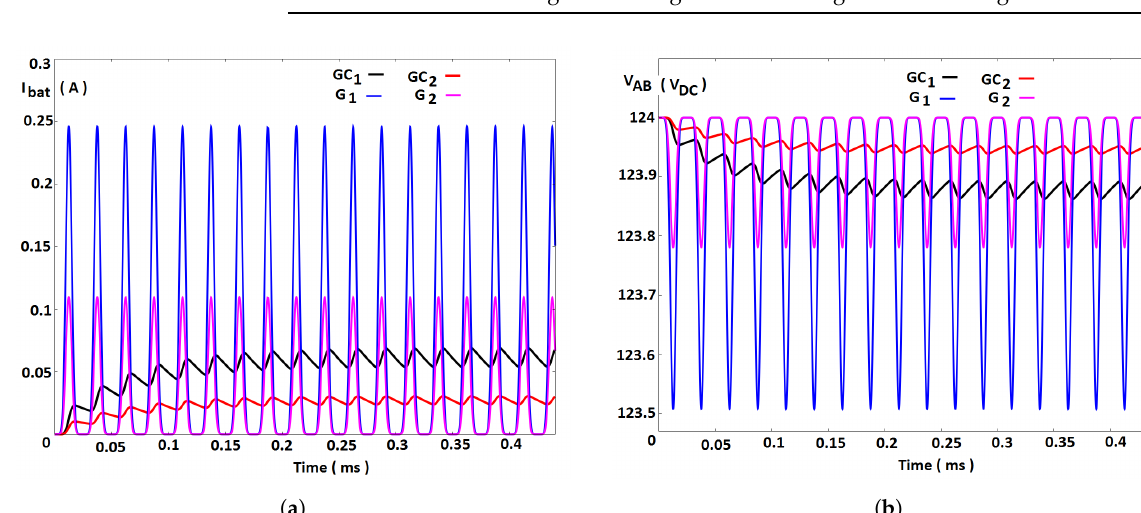
Figure 6. Case I. ( a ) Battery current. ( b ) Voltage V AB .